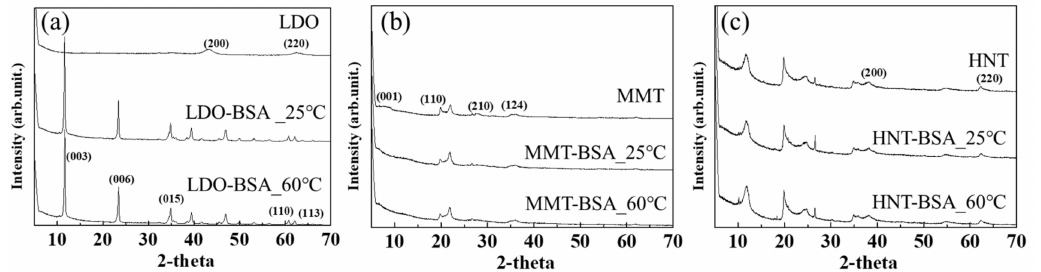
Figure 3. X-ray di ff raction patterns of ( a ) LDO, ( b ) MMT and ( c ) HNT with bovine serum albumin at 25 ◦ C and 60 ◦